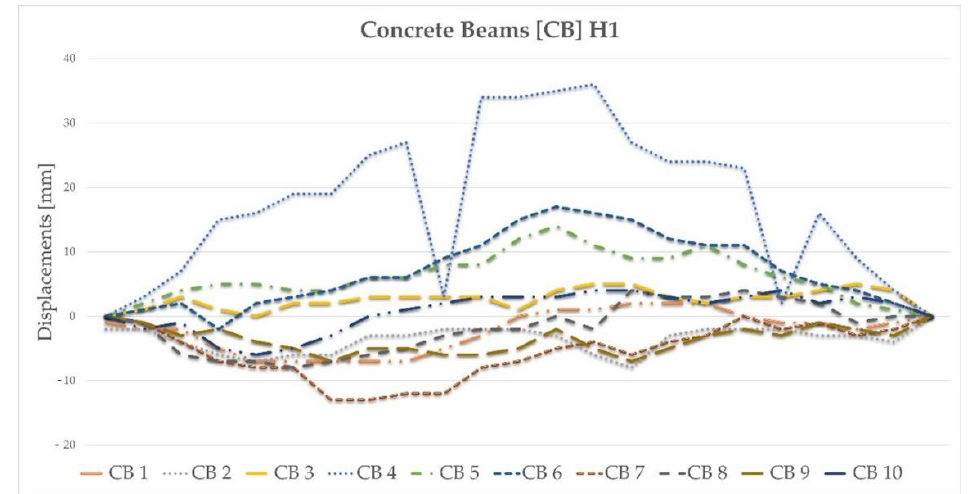
Figure 5. The result of changes in the geometry of the girders as a result of the impact.